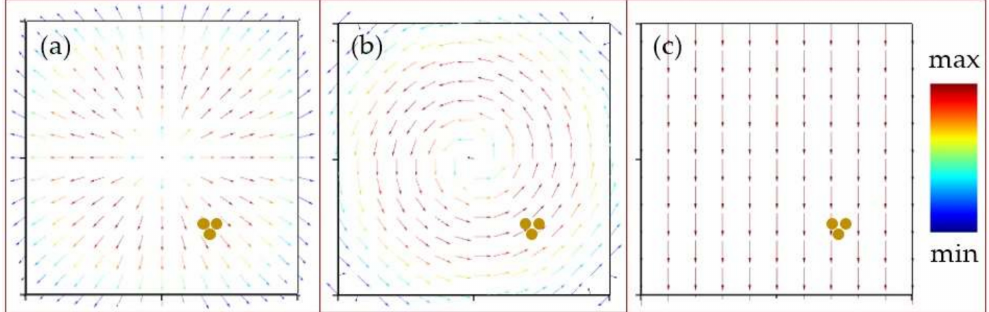
Figure 4. Vector plot of electric field amplitude in the cases of ( a ) a Laguerre–Gaussian beam with radial polarization, ( b ) a Laguerre–Gaussian beam with azimuthal polarization and ( c ) a plane wave with linear polarization. The location of the nanorod trimer in each case is shown by the three yellow dots.